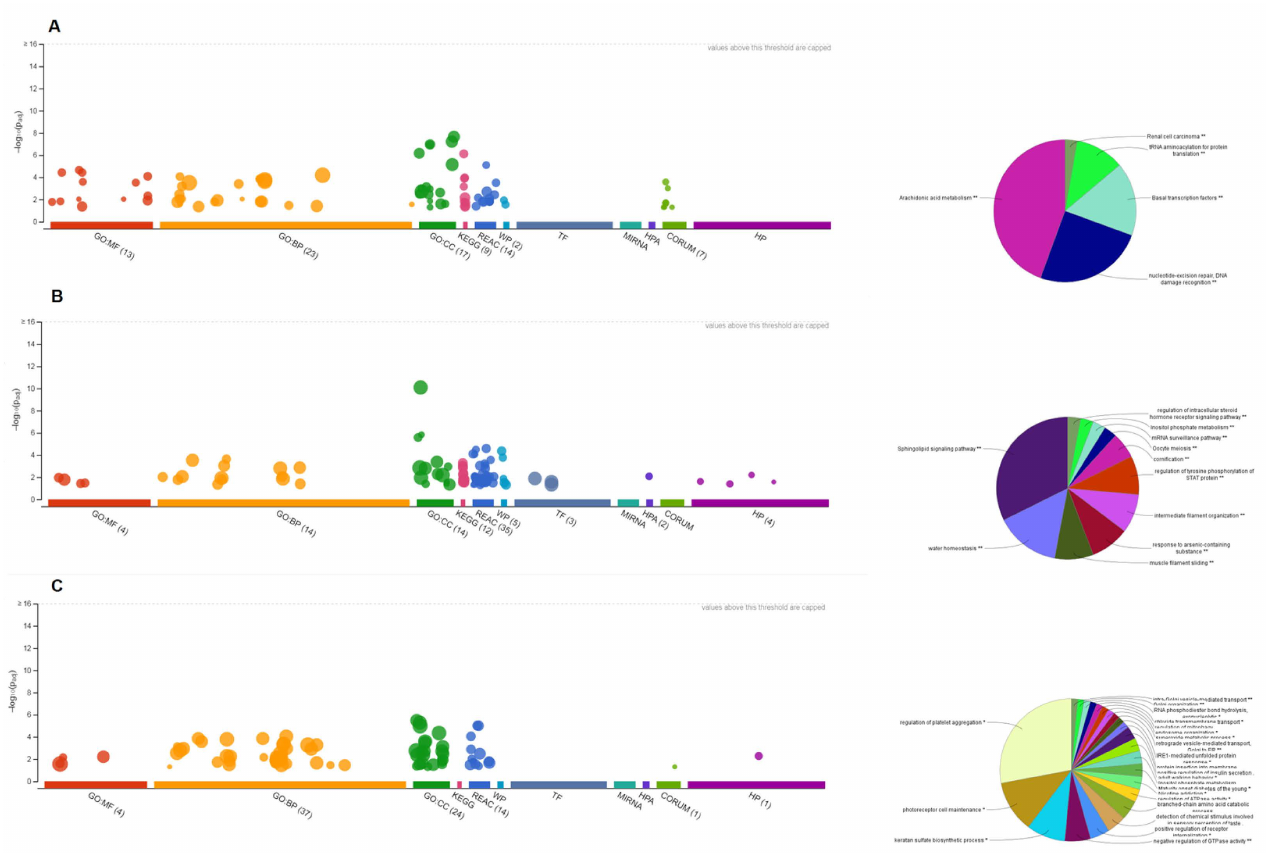
Figure 5. Enrichment analysis of the pathways related to CM (core module), CN (core nodes), DN (driver nodes); the visible output in GO terms is an interactive Manhattan plot that illustrates the enrichment analysis results: ( A ) this figure represents the result of a multiquery with CM; ( B ) this figure represents the result of a multiquery with CN; ( C ) this figure represents the result of a multiquery with DN. * and ** denoted that the biological pathways are significantly different at p < 0.05 and p < 0.01 levels,